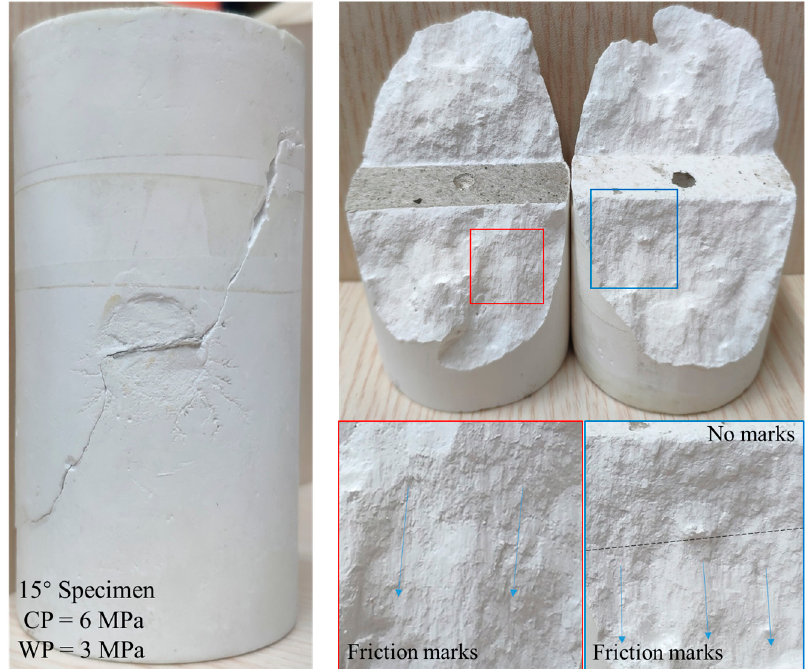
Figure 11. Crack surfaces of specimens after failure.